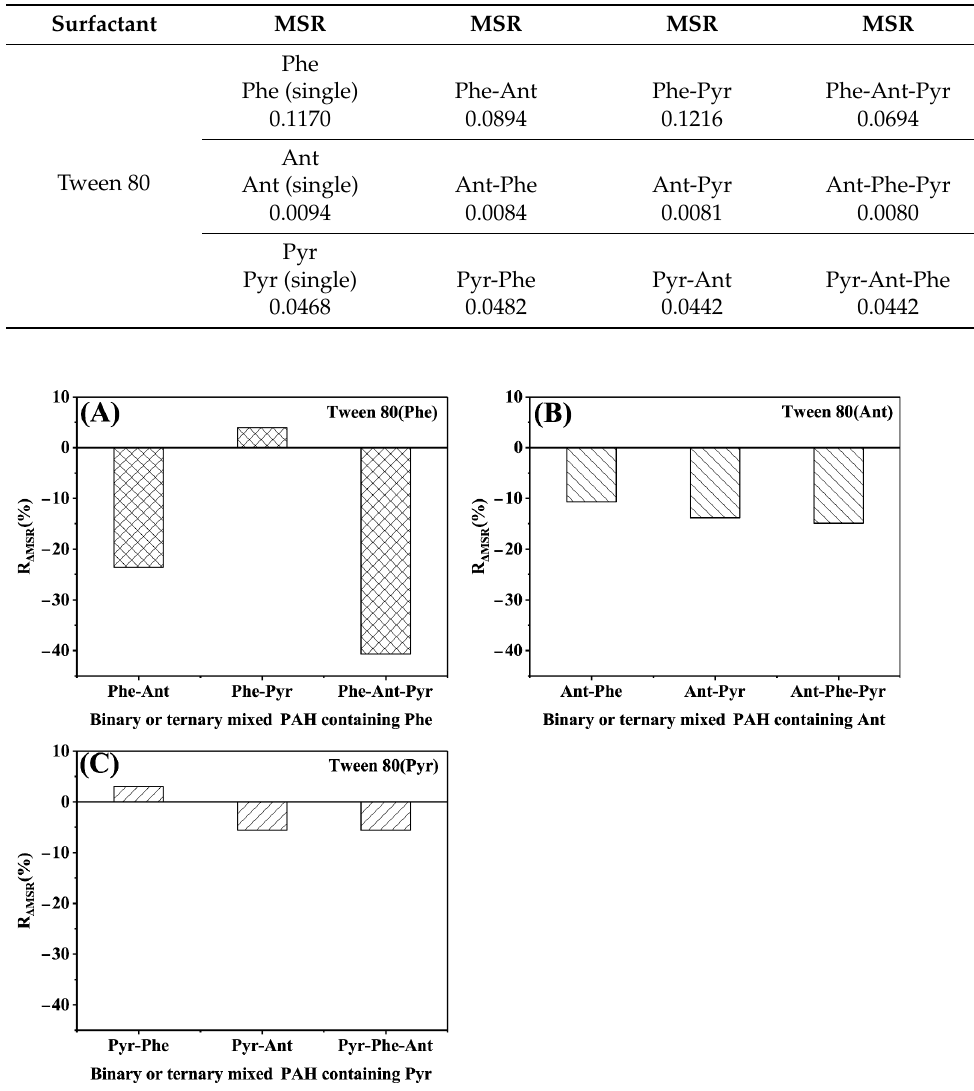
Figure 2. R Δ MSR of Phe ( A ), Ant ( B ) and Pyr ( C ) in binary and ternary co ‐ solubilization systems in Figure 2. R ∆ MSR of Phe ( A ), Ant ( B ) and Pyr ( C ) in binary and ternary co-solubilization systems in Tween 80 micellar solutions. Tween 80 micellar